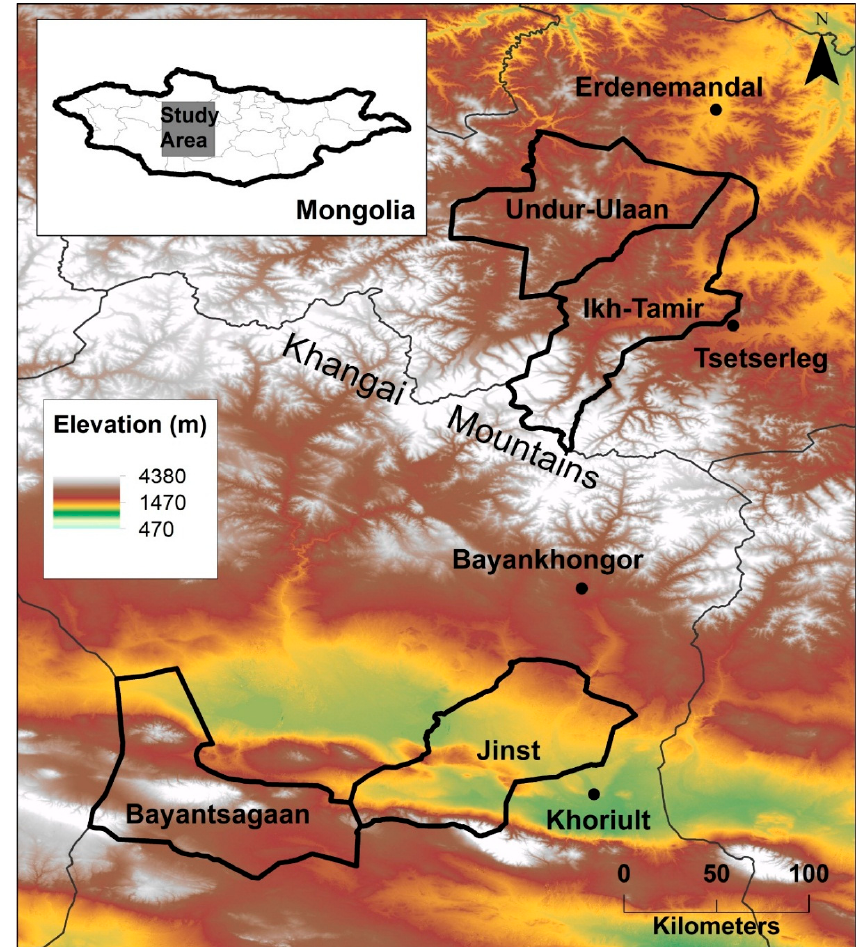
Figure 1. Location map of central Mongolia for the Northern soums of Ikh-Tamir and Undur-Ulaan in Akhangai aimag , and Southern soums of Jinst and Bayaantsagaan in Bayankhongor aimag . The nearest corresponding meteorological measurement stations are Erdenemandal and Tsetserleg in the north and Bayankhongor and Khoruilt in the south.